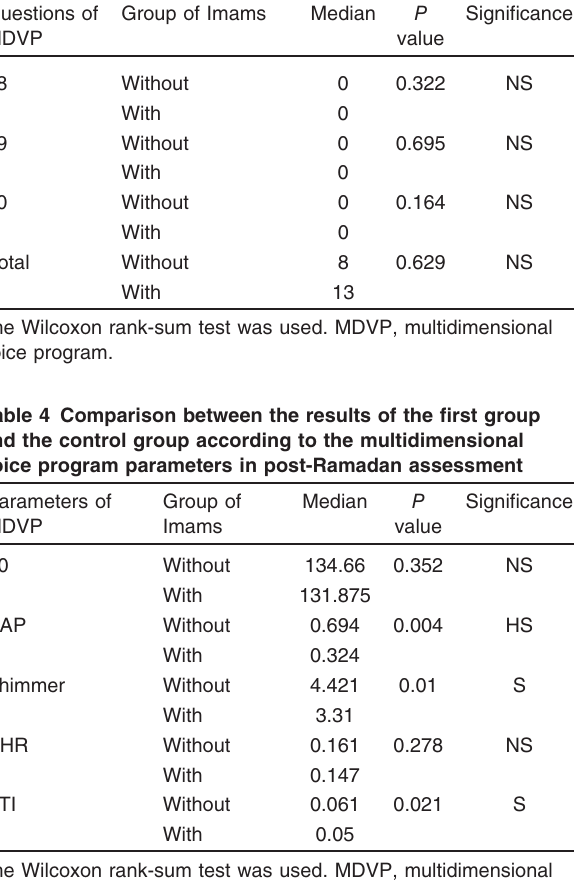
The Wilcoxon rank-sum test was used. MDVP, multidimensional voice program; NHR, noise-to-harmonic ratio; RAP, relative average perturbation.